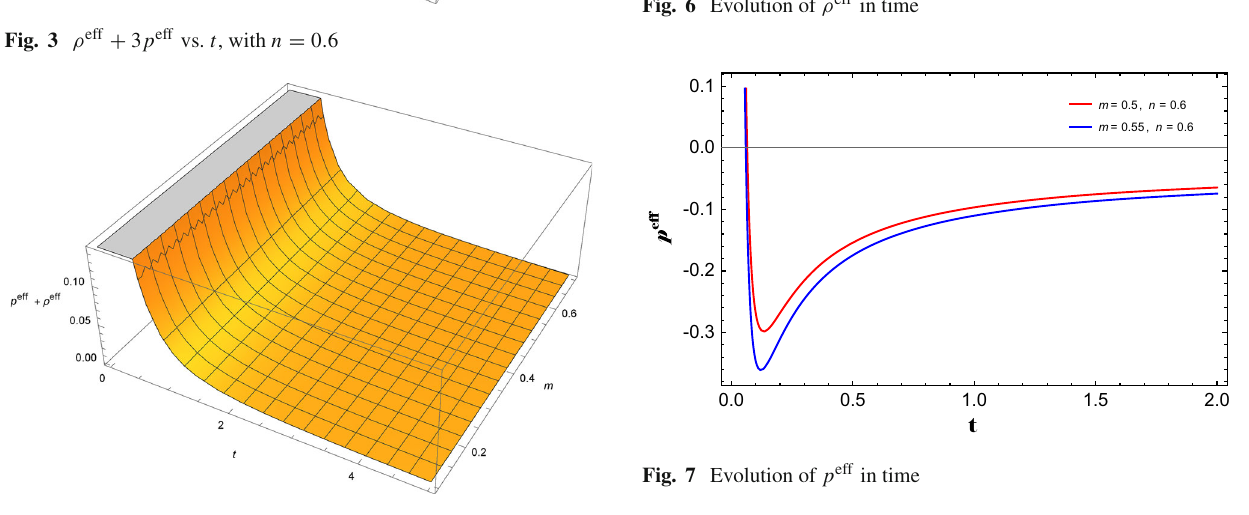
Fig. 4 ρ eff + p eff vs. t , with n = 0 . 6